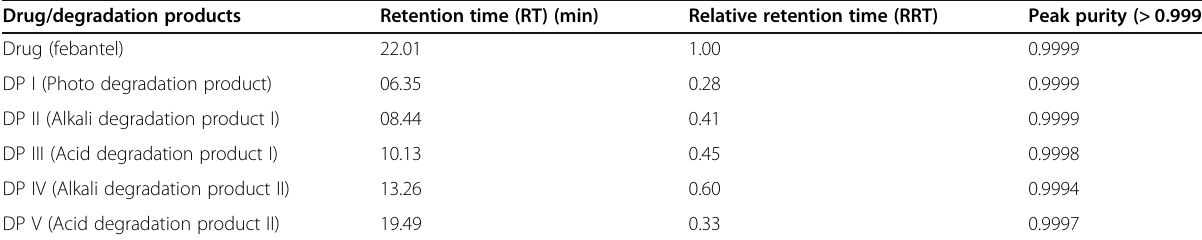
Table 2 Retention time, relative retention time, and peak purity data of febantel and its degradation products Drug/degradation